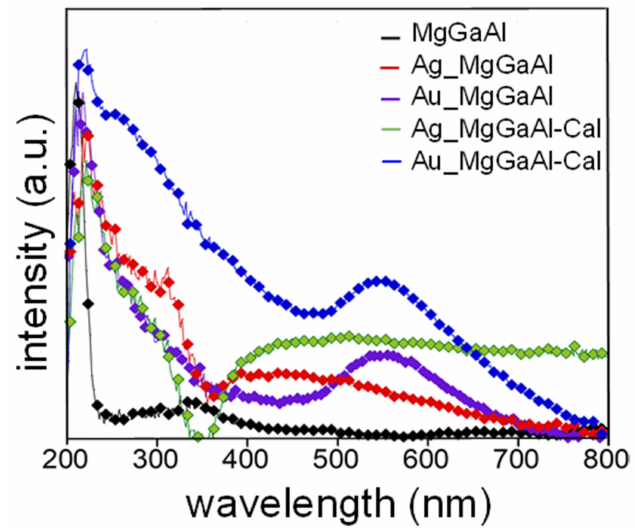
Figure 4. UVDR spectra of the studied